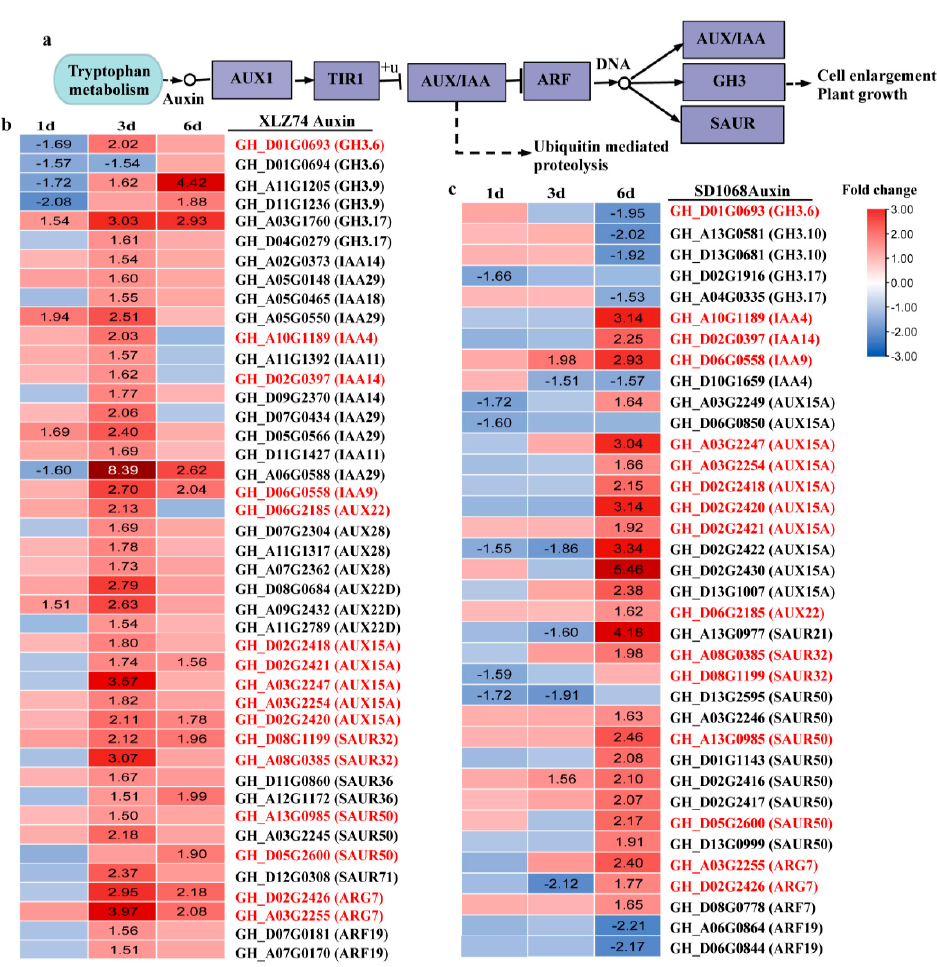
Figure 6. The expression patterns of Auxin-related genes in XLZ74 and SD1068. The results were based on the RNA-seq data. ( a ) A simple diagram to show the relationship of the genes and Auxin. ( b , c ) The heatmaps were generated based on the RNA-seq data. The number in box indicates the expression fold change of the gene (only those with a ≥ 1.5-fold difference are shown). MC-induced downregulated and upregulated expression are indicated by blue and red colors, respectively. Gene ID marked with red represents common gene between XLZ74 and SD1068. All the numbers in heatmap were fold change.